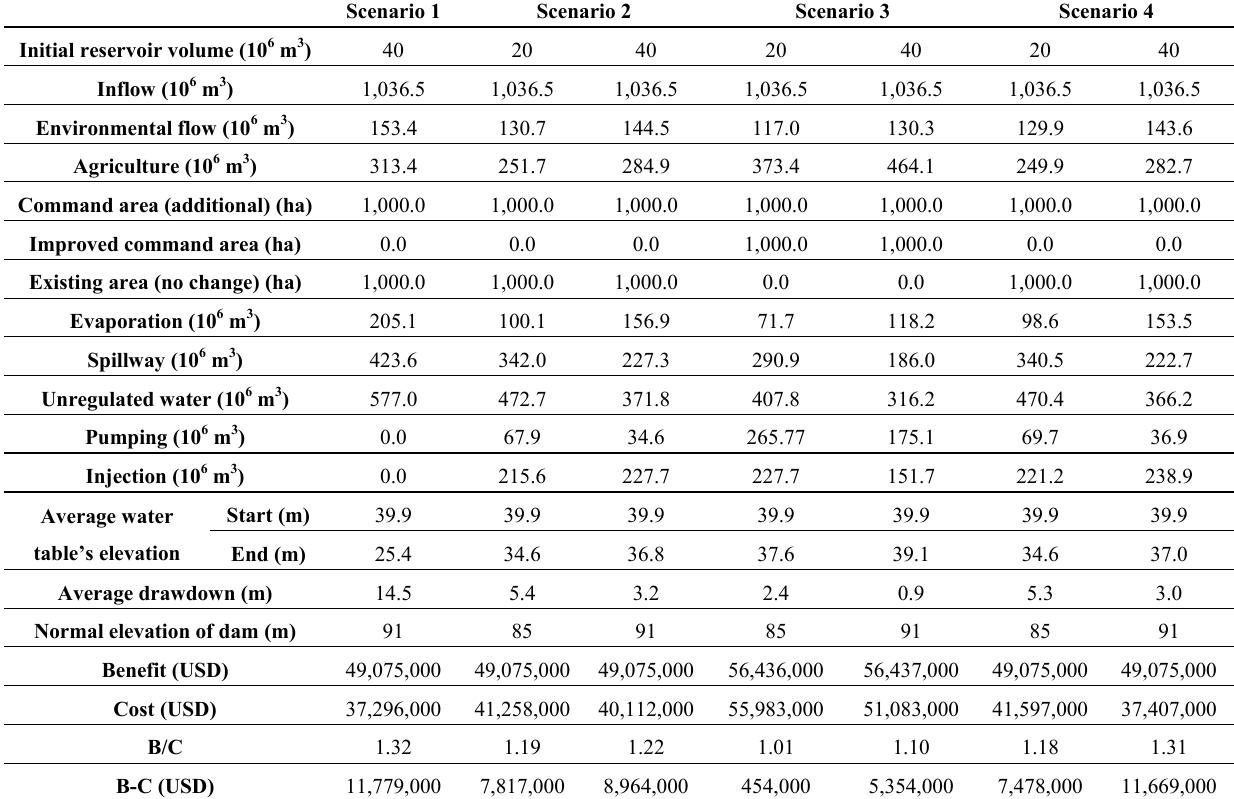
Table 4. Water supply and economic analysis of scenarios after 40 years of